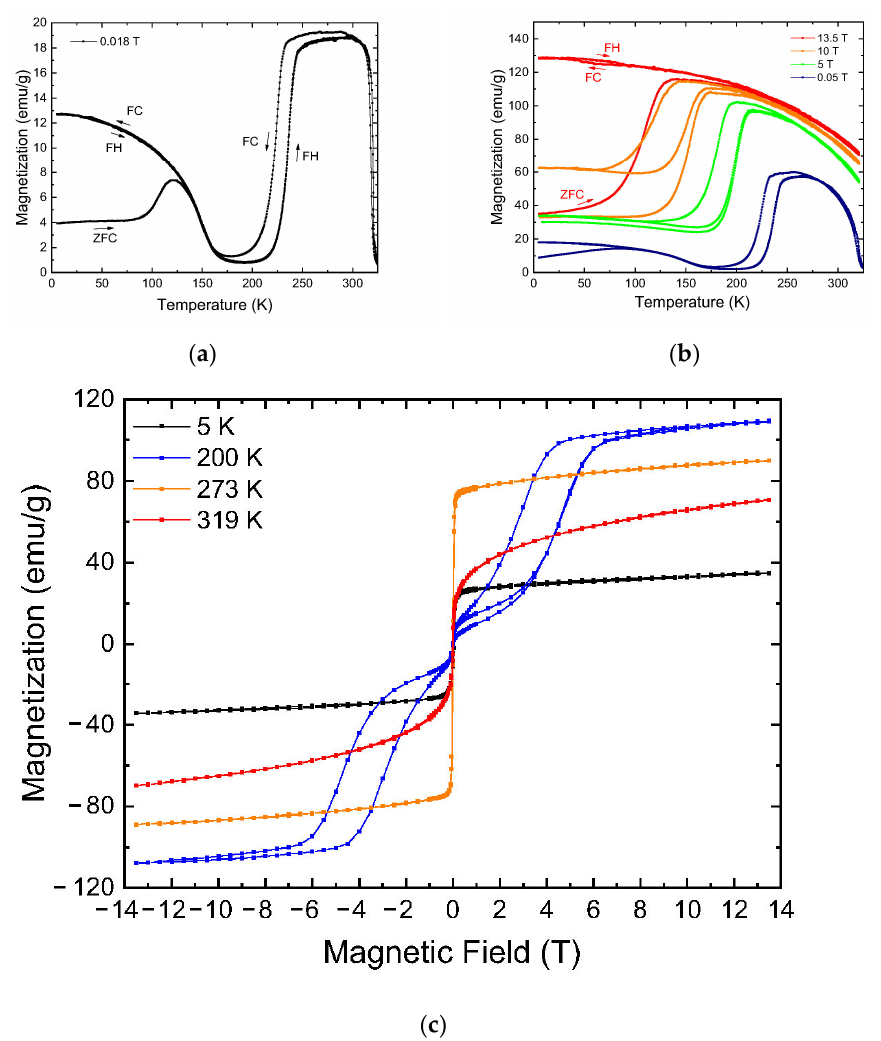
Figure 1. Graph showing the dependence of the sample’s magnetization (M) on temperature (T): ( a )—in a field of 0.018 T; ( b )—in fields of 0.05, 1, 3.5, 10, and 13.5 T; ( c )—the dependence magnetization (M) on magnetic field (T) at temperatures 5, 200, 273, 319 K.